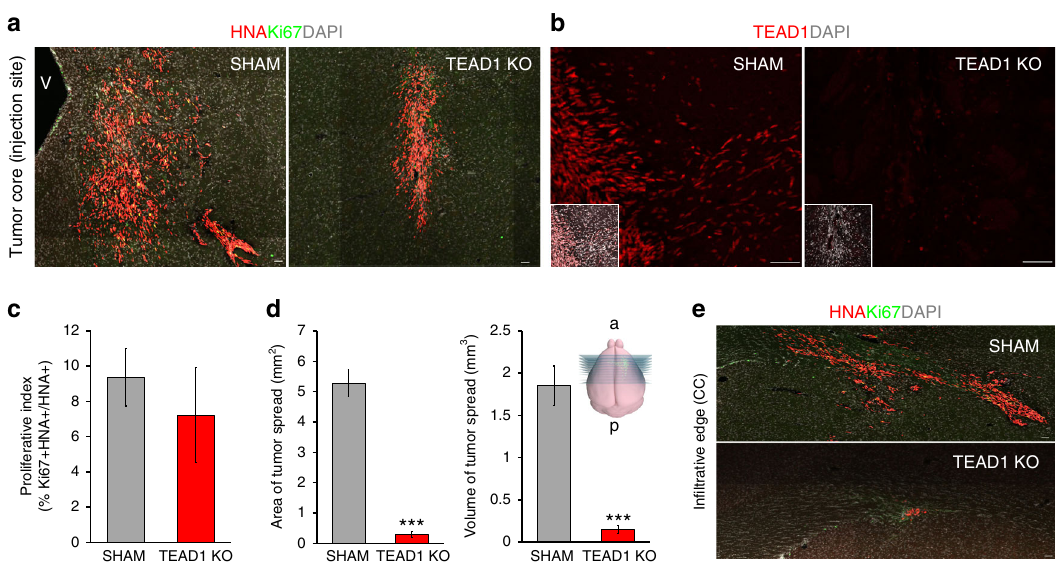
Fig. 4 In vivo in fi ltration is highly impaired in TEAD1KO GBM xenografts. a Representative immuno fl uorescent histology of tumor engraftment and core growth near the injection site in sham and TEAD1KO cells, 3.5 months after orthotopic xenotransplantation. b Representative immuno fl uorescence images of TEAD1 expression, con fi rming the stable loss of TEAD1 in TEAD1KO xenografts. Insets represent the entire TEAD1 immuno fl uorescence image with DAPI co-labeling. c Quanti fi cation of cell proliferation in sham and TEAD1KO cells at 3.5 months post xenotransplantation ( n = 3 animals per condition; Ki67 + cells counted out of all HNA + cells in 11 serial histological sections. Bars represent mean ± SEM). d Quanti fi cation of migratory tumor spread in sham and TEAD1KO cells at 3.5 months post xenotransplantation ( n = 3 animals per condition; *** p = 0.0003 for both. Area = sum of areas with tumor spread in 11 serial coronal sections. Volume = average area × the distance between the fi rst and the last serial section examined. Bars represent mean ± SEM). Schematic of the analyzed mouse brain serial coronal sections is depicted on the right. e Representative example of in fi ltrative tumor spread along the corpus callosum in sham and TEAD1KO cells at 3.5 months post xenotransplantation. HNA: human nuclear antigen, CC: corpus callosum, v: ventricle, a anterior, p: posterior. Scale bar = 50 μ